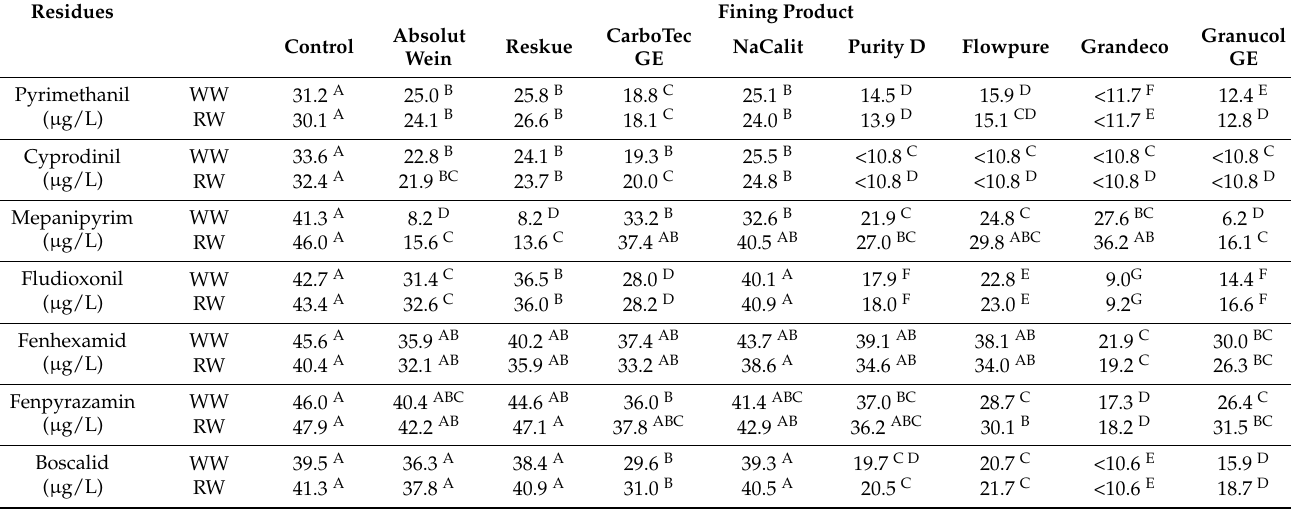
Table 5. Concentration of botryticides before and after treatment with different fining agents.